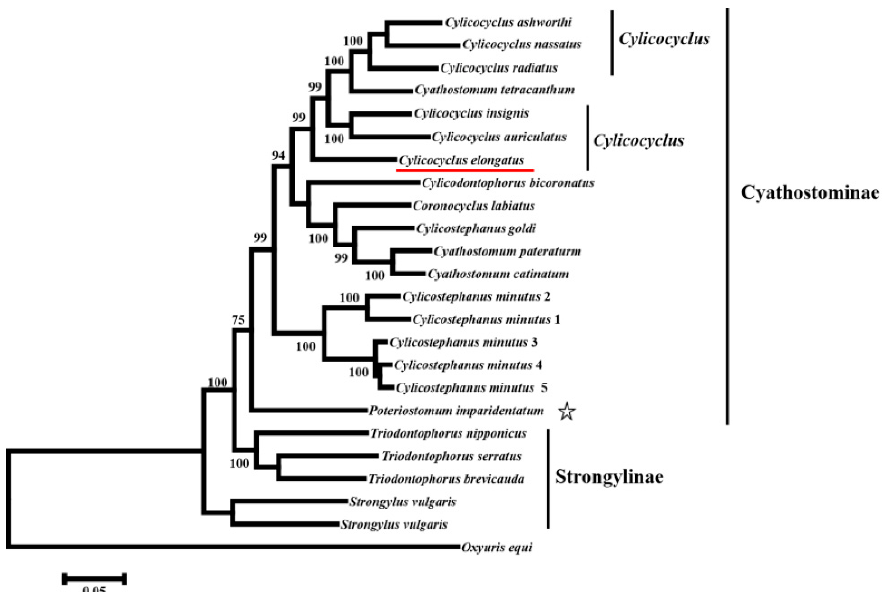
Figure 2. Phylogenetic analyses reconstructed using concatenated nucleotide sequences of 12 PCGs of complete mt genomes in 23 Strongylidae species. The tree was developed using ML method. Oxyuris equi is an outgroup. C. elongatus in current study is underlined.